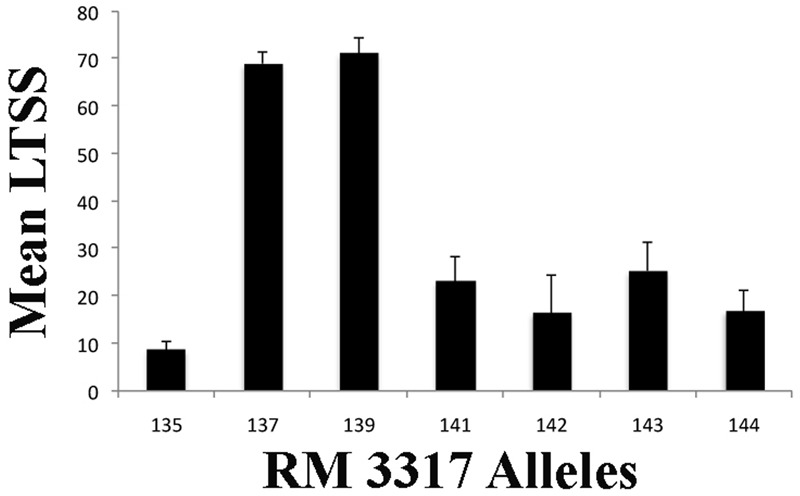
Association of genotypic effects of RM3317 alleles with mean LTSS scores at the qLTSS4-1 locus. Shown is the mean low temperature seedling survival (LTSS) for the RMC accessions having the same RM3317 allele. Alleles 137 and 139 are predominantly found in JAPONICA accessions and alleles 135, 141, 142, 143, and 144 are predominantly found in INDICA accessions (Supplementary Table S4). Error bars indicate the standard error of LTSS for the accessions having a particular allele.